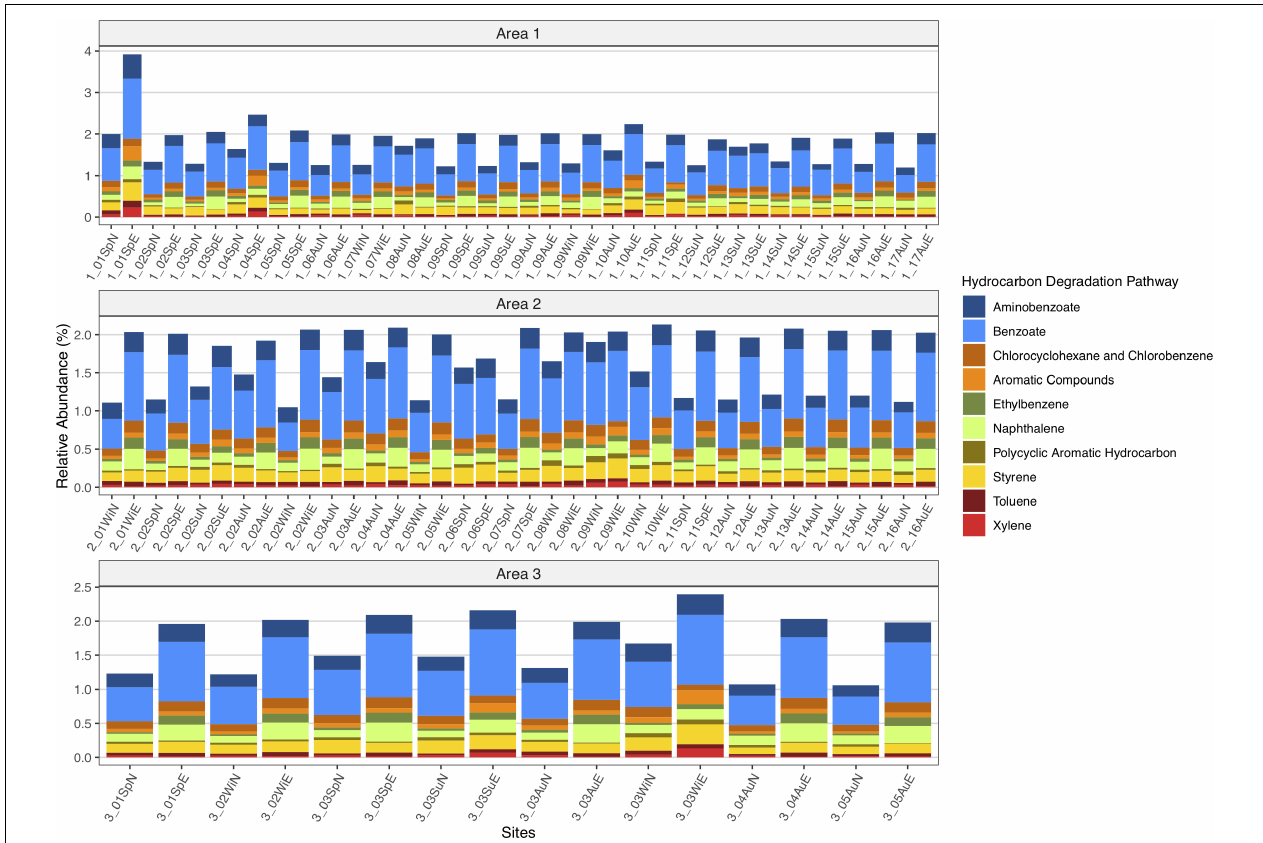
FIGURE 8 | Predicted relative abundance of genes involved in ten petroleum hydrocarbon degradation metabolisms present in the natural microbial communities and in oil-enriched communities, for the 47 sampled sites, distributed per Area (1, 2, and